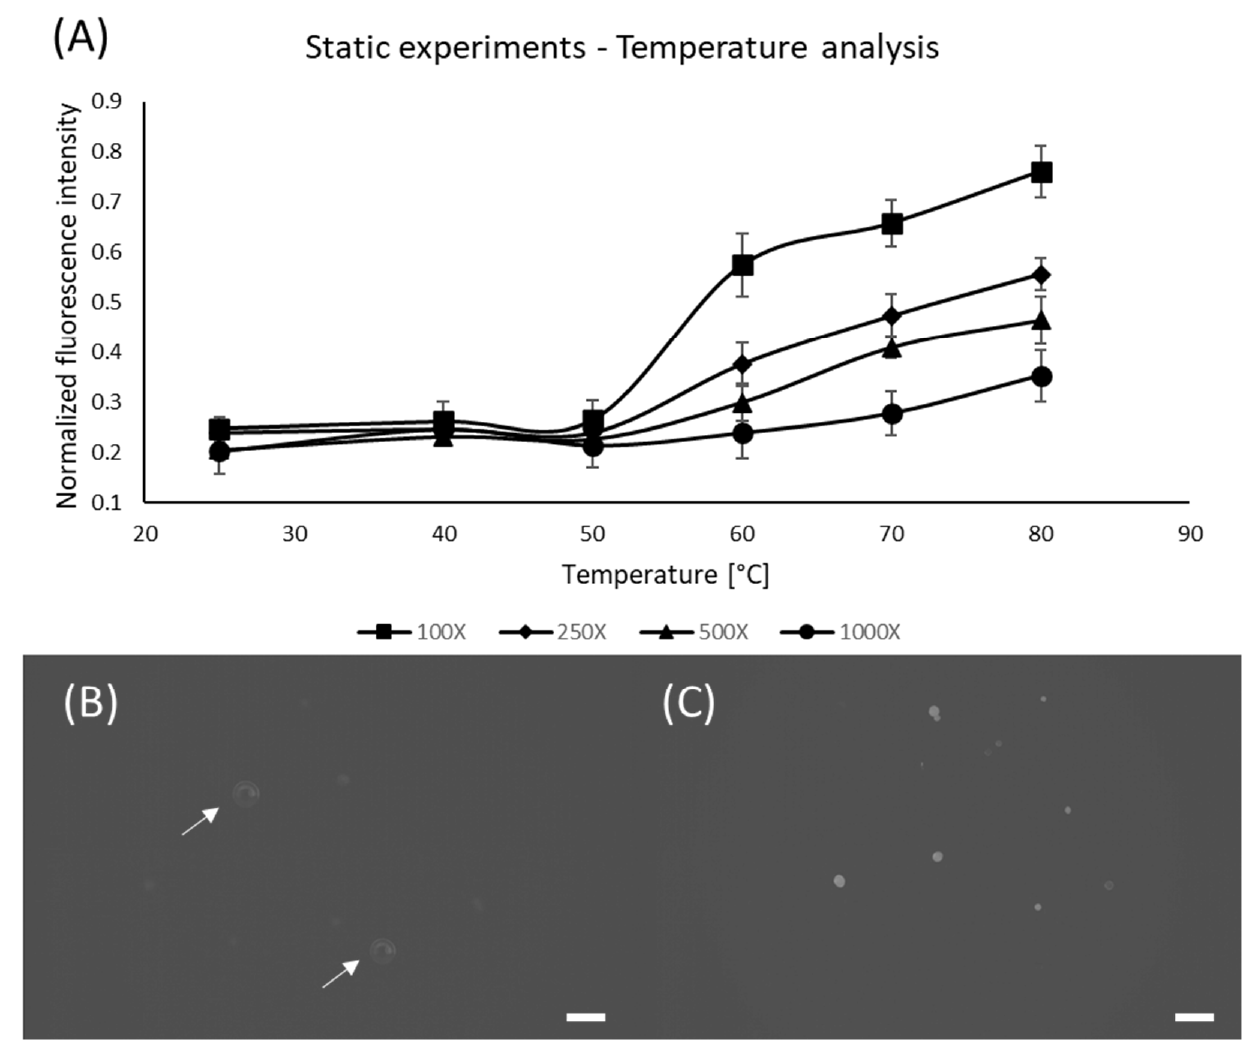
Figure 3. Effect of Nile Red concentration and temperature for static samples placed inside the oven for 10 min. ( A ) Graph showing the influence of different Nile Red concentrations and oven temperatures on staining performance; ( B ) PE microspheres stained using 100X Nile Red at 25 ◦ C; ( C ) PE microspheres stained using 100X Nile Red at 80 ◦ C; Arrows were added to indicate the particles of interest. Scale bars are 100 µm.